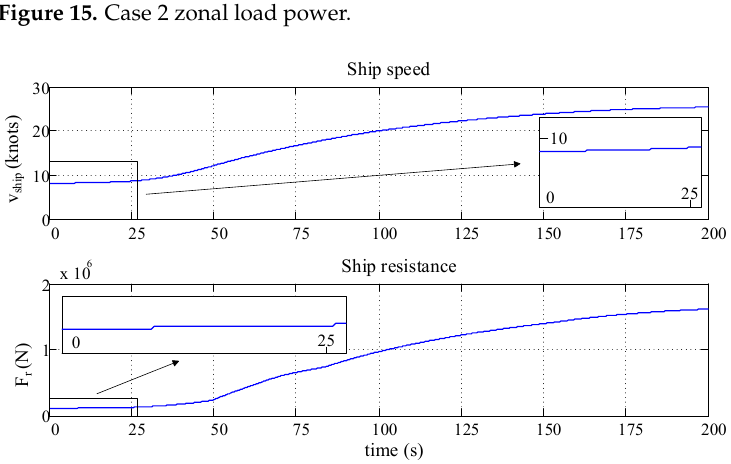
Figure 16. Case 2 ship speed and resistance.